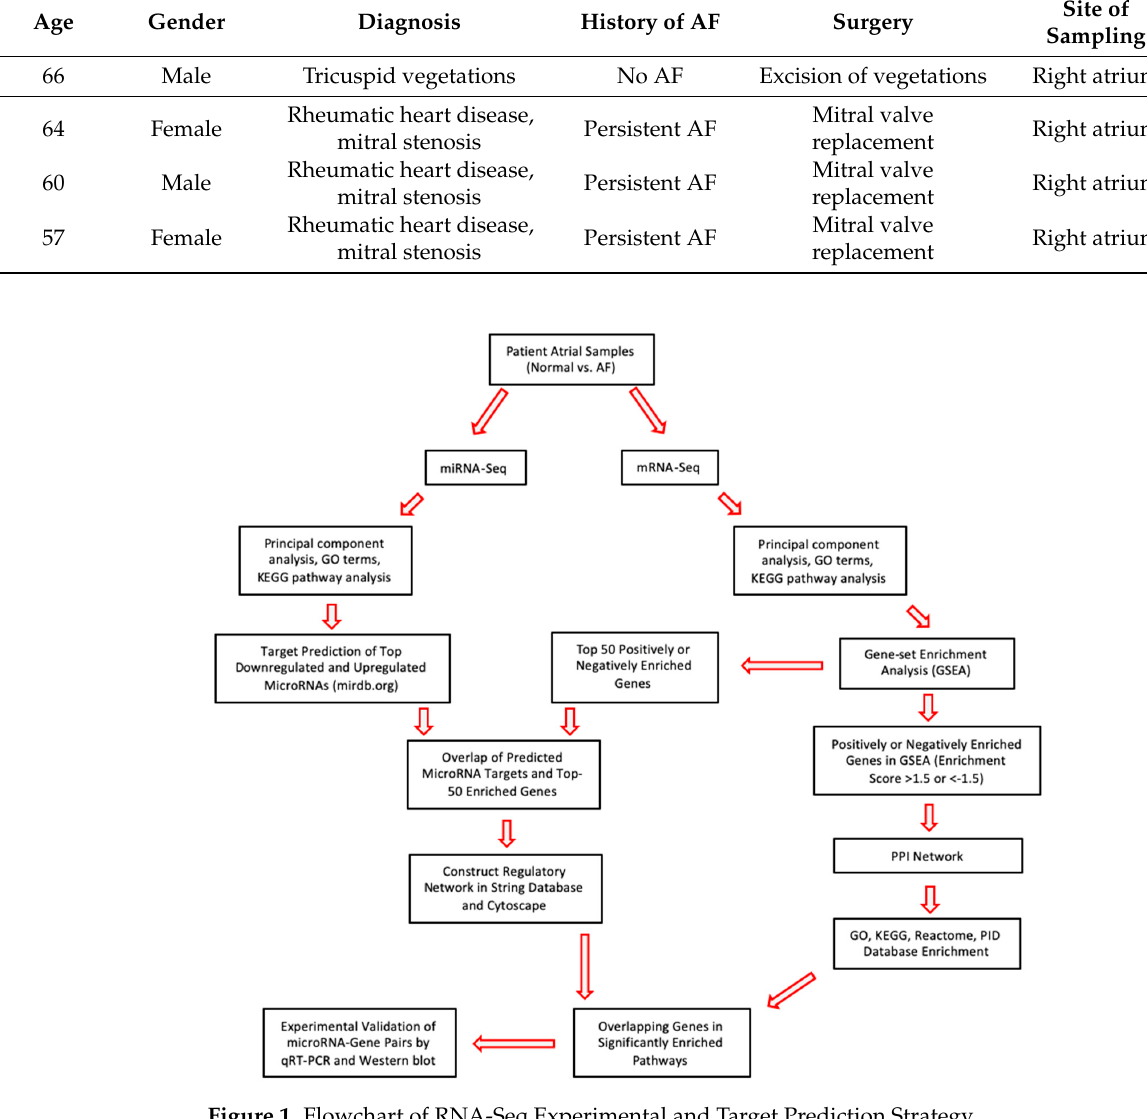
Figure 1. Flowchart of RNA-Seq Experimental and Target Prediction Strategy.